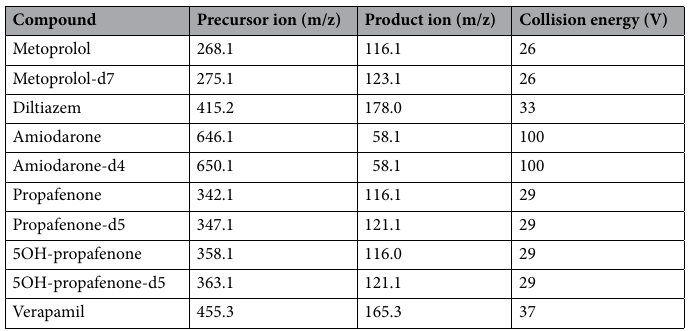
Table 2. Multiple reaction monitoring (MRM) transitions and collision energy of six anti-arrhythmic compounds and internal